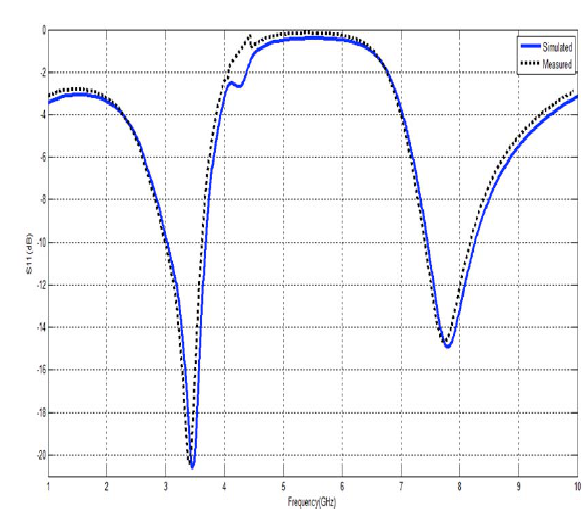
Figure 8: Simulated and measured S11 responses of the quasi-fractal